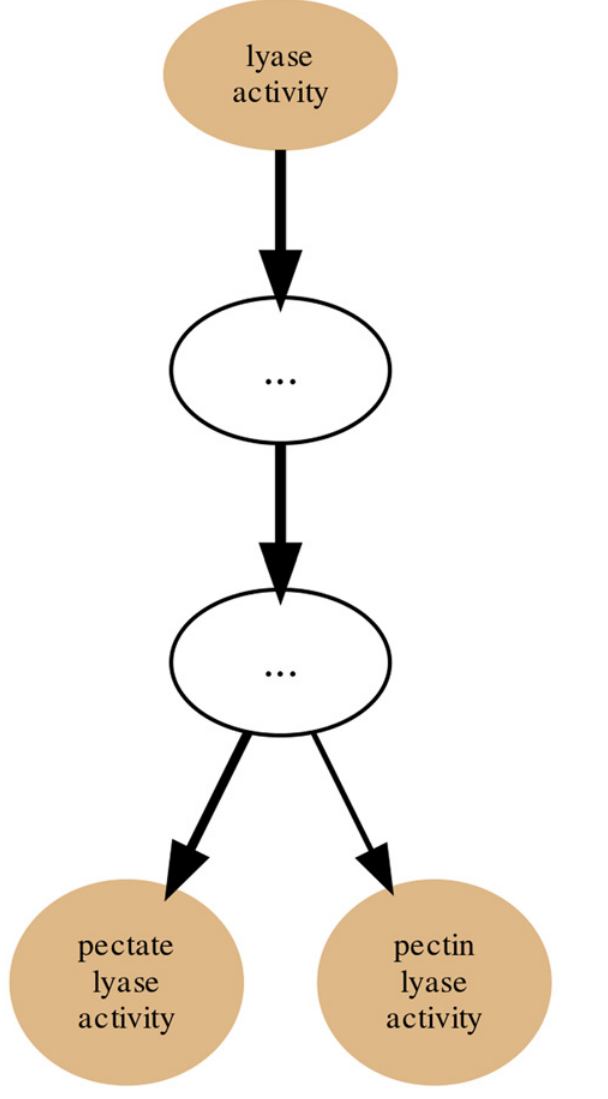
Fig 6. PL1 Set annotation graph re-rooted at the lyase activity term. Annotation graph of the PL1 (CAZy family) Set for the GO molecular function sub-ontology re-rooted at the lyase activity term.